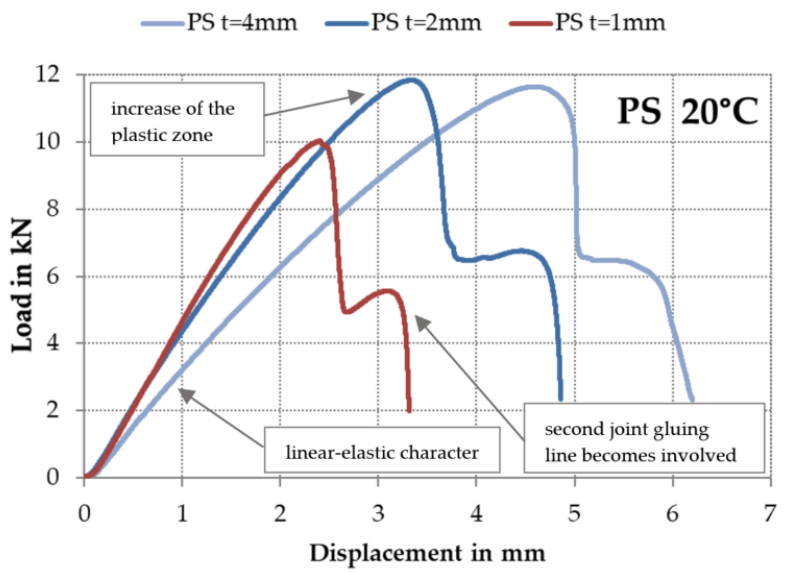
Figure 8. Force vs. displacement plot for various adhesive layer thicknesses t = 1, 2 and 4 mm at 20 °C.